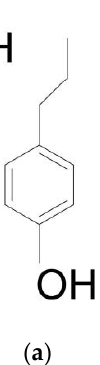
Figure 2. Three types of C 6 C 3 monomer units in lignin [25]. ( a ) p-Hydroxyphenyl unit(H); ( b ) Guaiacyl unit (G); ( c ) Syringyl unit (S).